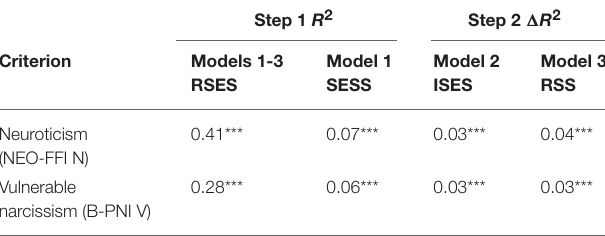
TABLE 4 | Results of multiple regression analyses predicting neuroticism and vulnerable